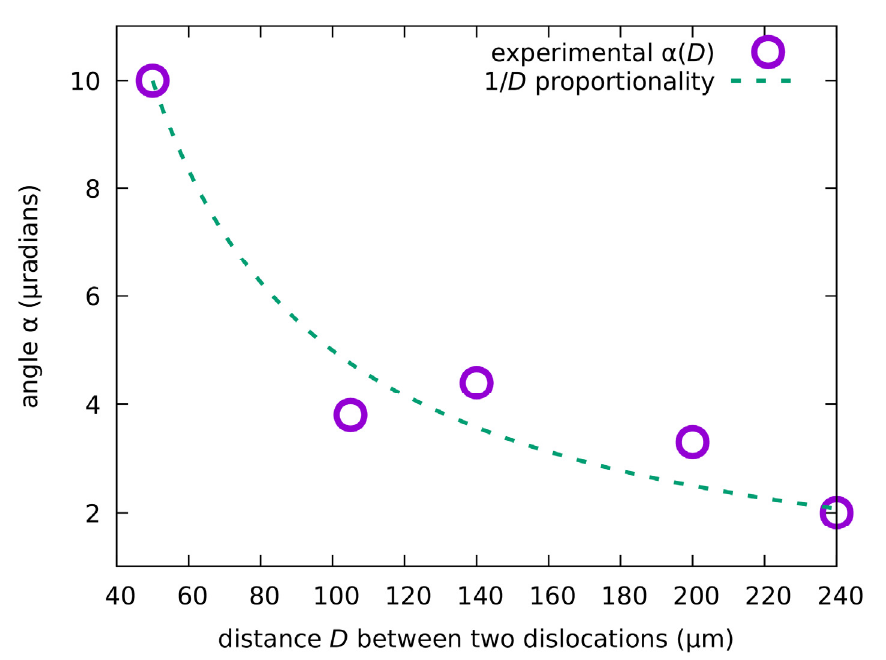
Figure 7. The dashed curve corresponds to | α | proportional to 1/ D , with the point D = 50 µ m, α = 10 µ radians being, by construction, on the curve. The circles are the measured modulus of α for five pairs of dislocations with opposite Burgers vectors that we can observe in Figure